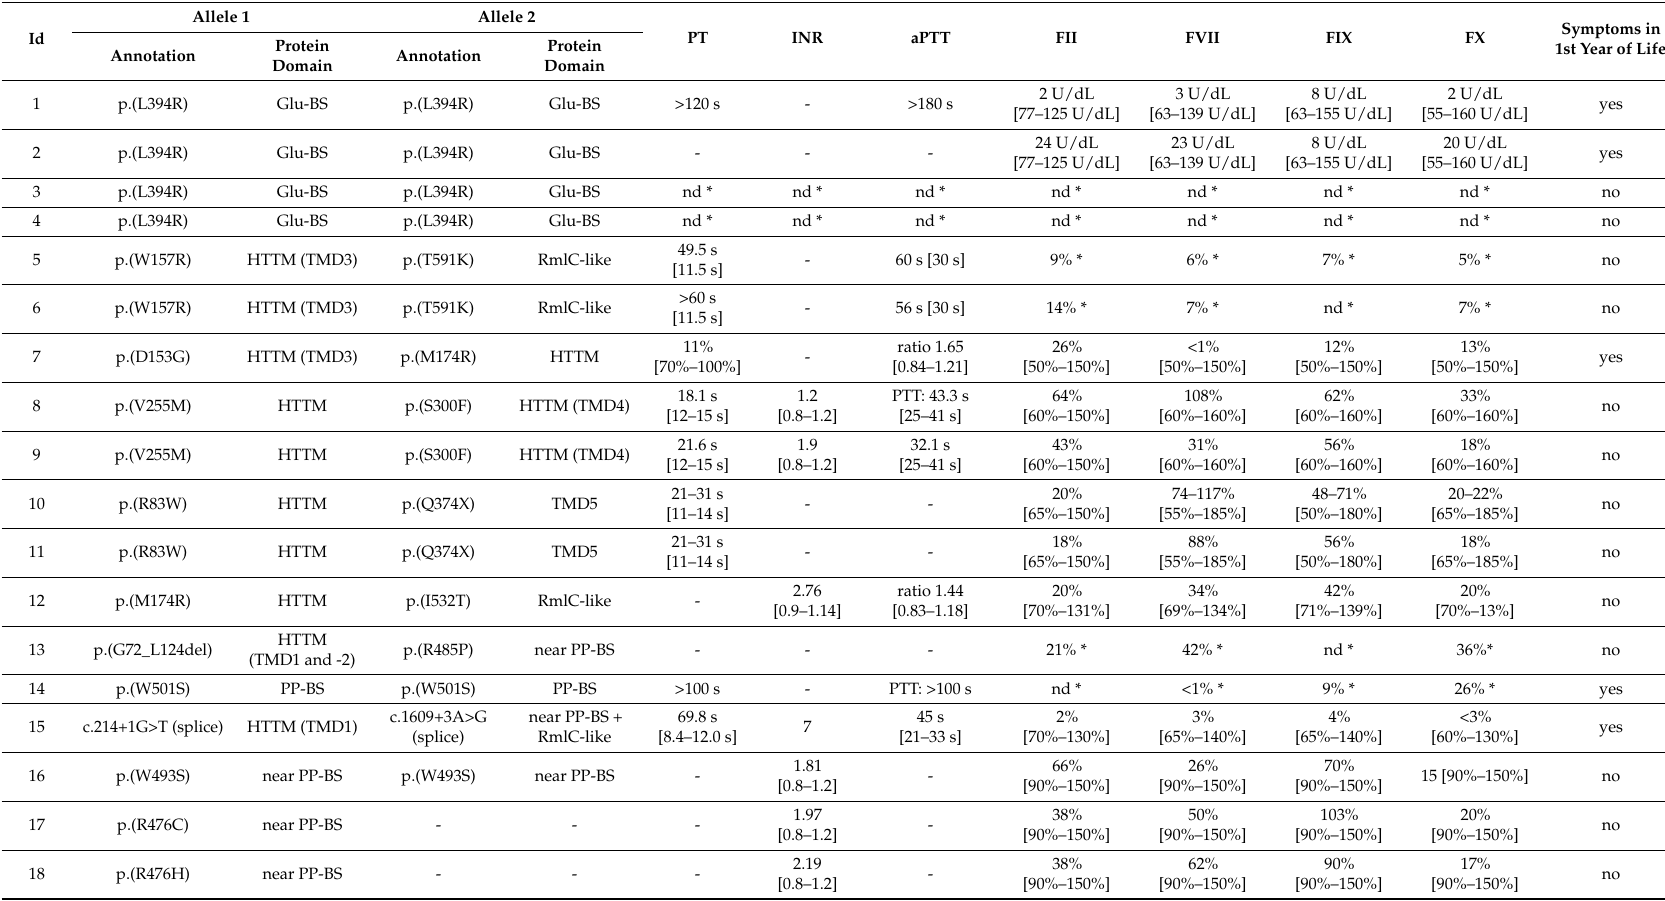
Table 8. VKCFD1 in patients with GGCX mutations. This table gives an overview of all patients in the analyzed cohort with VKCFD1. For each patient, the GGCX mutations on both alleles and the affected protein domain are stated (protein annotation). Further, an overview of the coagulation factor function (percent of normal activity or in U/dL or U/mL), aPTT and PT is given, it is stated if patients were symptomatic within the first year of life. Reference values are stated between brackets if they were mentioned in the original